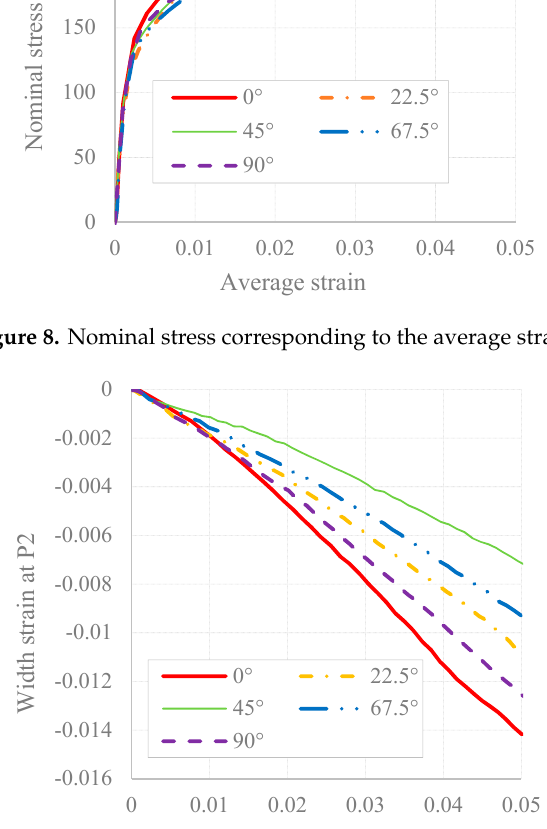
Figure 9. Width strain at P 2 respect to the average strain.